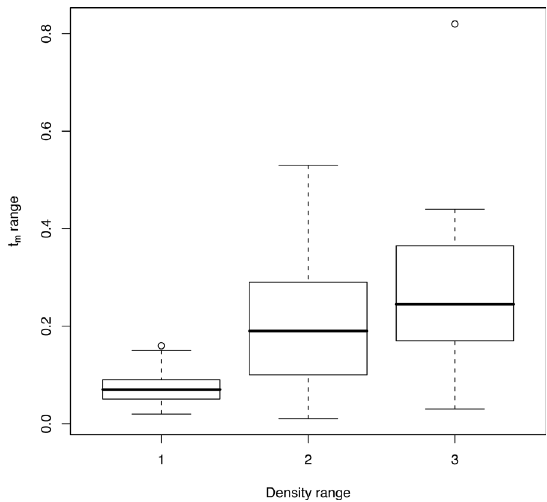
Fig. 3. Effect of density on outcrossing rate at the population level over three genera Abies , Picea and Pinus .